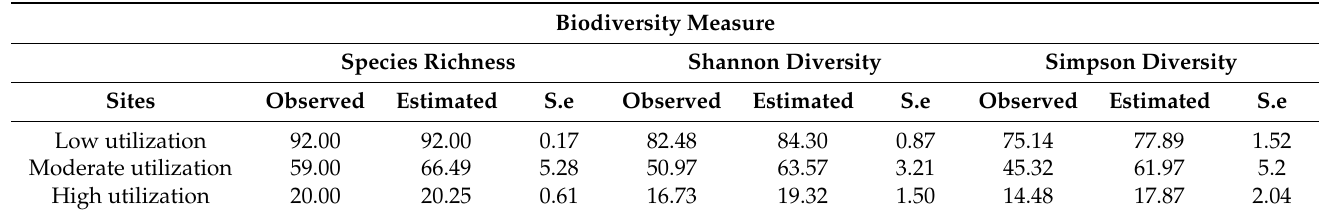
Table 1. Estimation of species biodiversity of land under different management